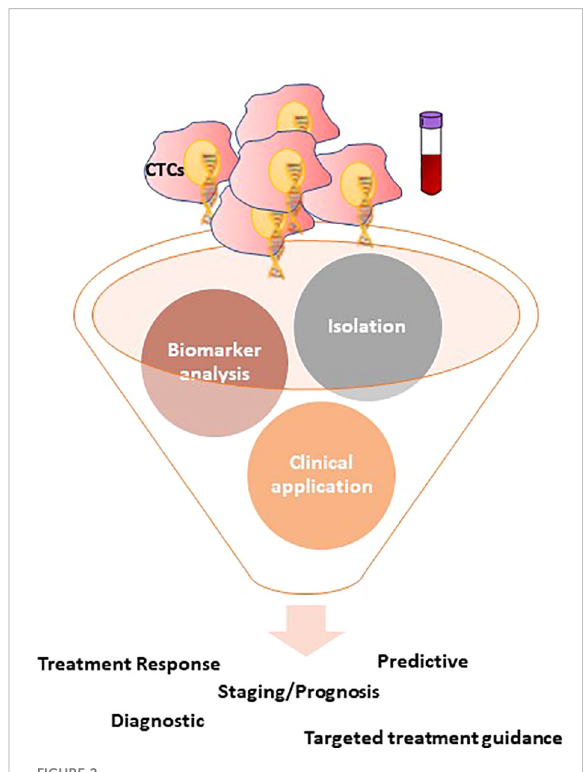
FIGURE 2 Overview of the CTCs detection technologies and the potential clinical applications of CTCs in CRC. CTCs isolation can usually be divided into two groups: physical isolation designed to exploit the differing physical belongings of blood components, such as size, deformity, and charge; and biological isolation, often utilizing antibody-based capture methods to enrich CTCs or deplete various blood cells. Following isolation, CTCs are open to a variety of downstream applications, focusing primarily on one of three categories: enumeration, characterization, and